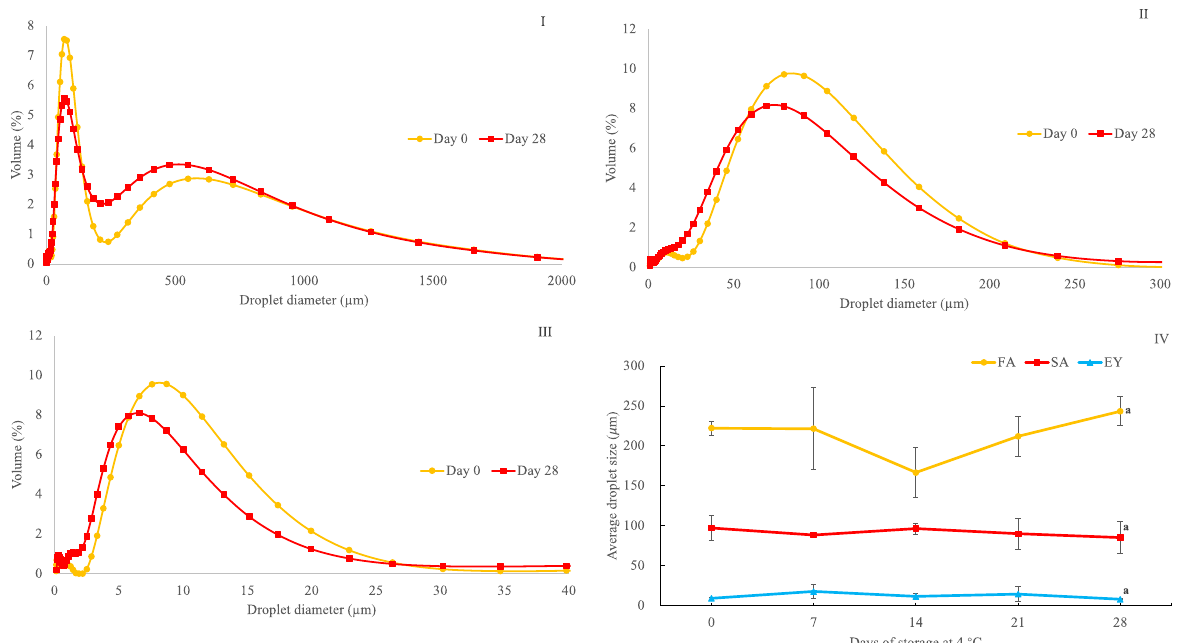
Figure 5. Droplet size distribution of mayonnaise and mayonnaise analog made with freeze-dried aquafaba ( I ), spray-dried aquafaba ( II ) and egg yolk ( III ); and volume average mean droplet diameter ( d 43 , µ m) ( IV ) of mayonnaise and mayonnaise analog as a function of time. The letter (a) refers to no significant difference among storage times according to Tukey’s test ( p < 0.05).